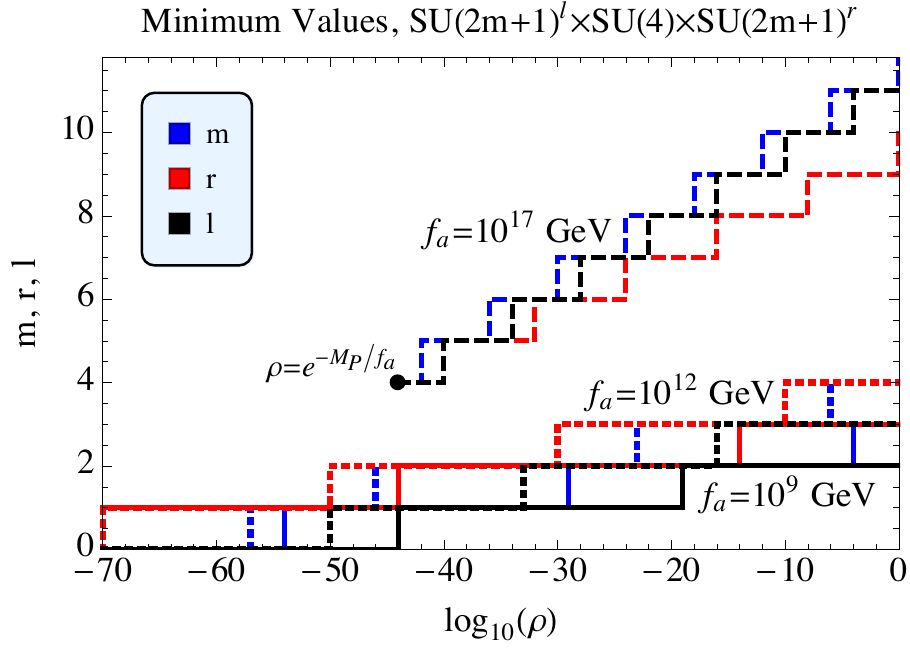
Figure 2 . Minimum values for m , ‘ and r consistent